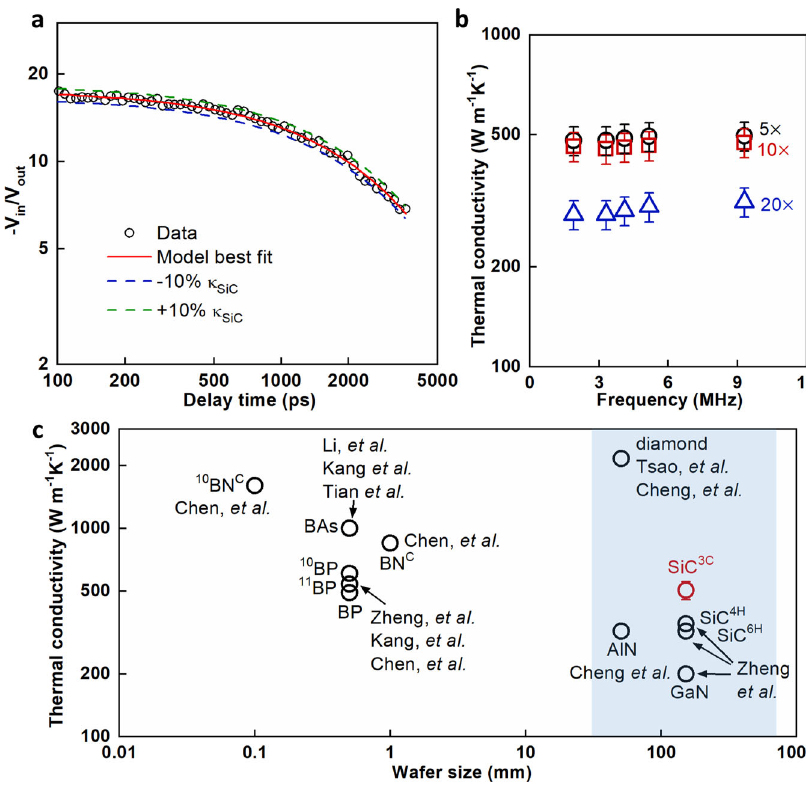
Fig. 2| High κ of3C-SiCbulk crystalsnearroomtemperature. a TDTRratio data (circles) and model fi tting (solid line) for 3C-SiC sample. The dash lines are model curves using κ 10% larger or 10% smaller than the best- fi t κ to illustrate the mea- surementsensitivity. b Dependenceofmodulationfrequencyandlaserspotsizeon